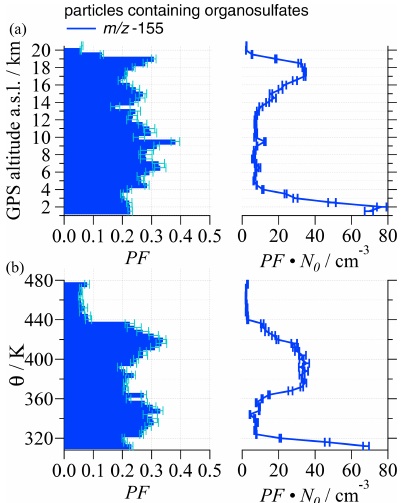
Figure 13. Vertically resolved fraction and number concentration of the particles containing organosulfates (here: glyoxal or gly- colic acid sulfate evident by the abundance of m/z − 155 in single- particle spectra) detected by the ERICA-LAMS as a function of (a) GPS altitude and (b) potential temperature θ . The left panels represent the particle fraction (PF) of the particle type. The right panels represent the scaled ERICA-LAMS number concentrations (PF · N 0 ). Uncertainty analysis is given in Sect.